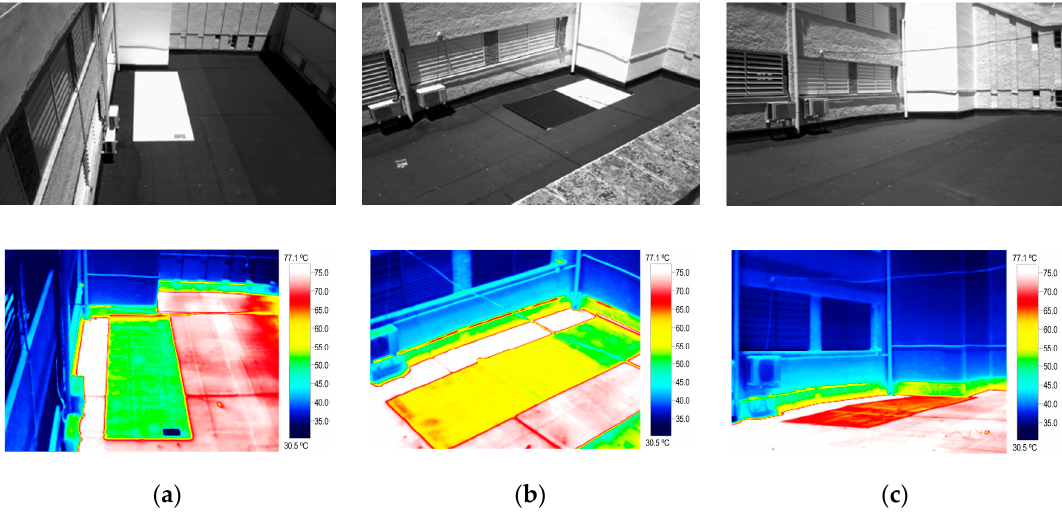
Figure 14. Case study 1: ( a ) thermographic image of albedo modification, ( b ) partial removal of the new sheet and ( c ) total removal of the new sheet.